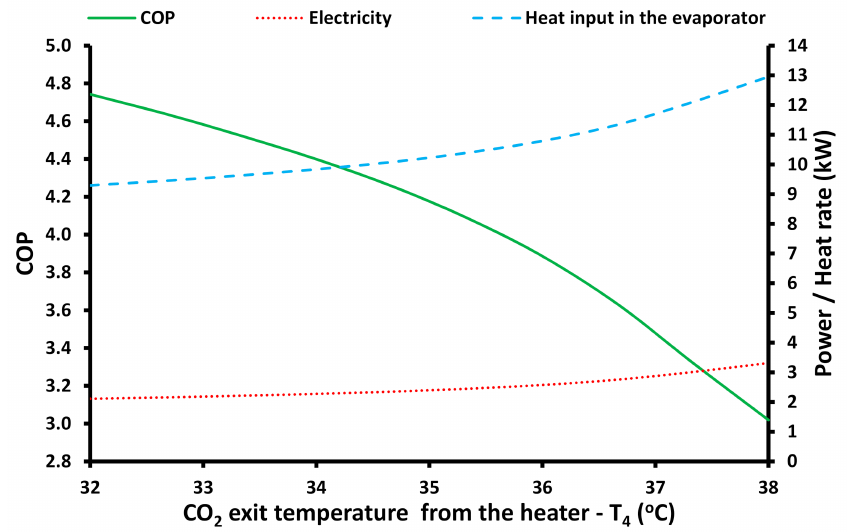
Figure 8. The impact of the CO 2 exit temperature from the heater on the COP, electricity consumption and heat input in the